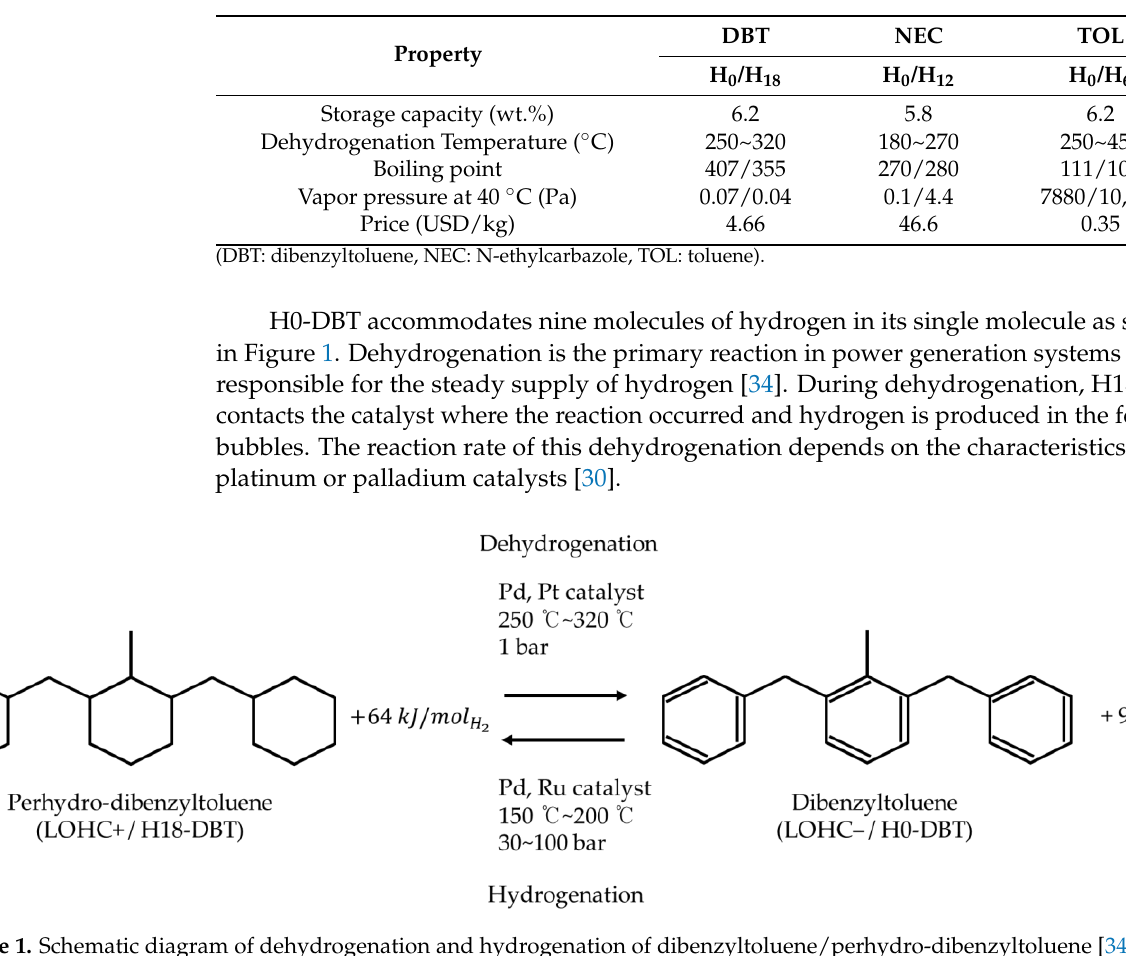
Table 3. Properties of LOHC materials [25].